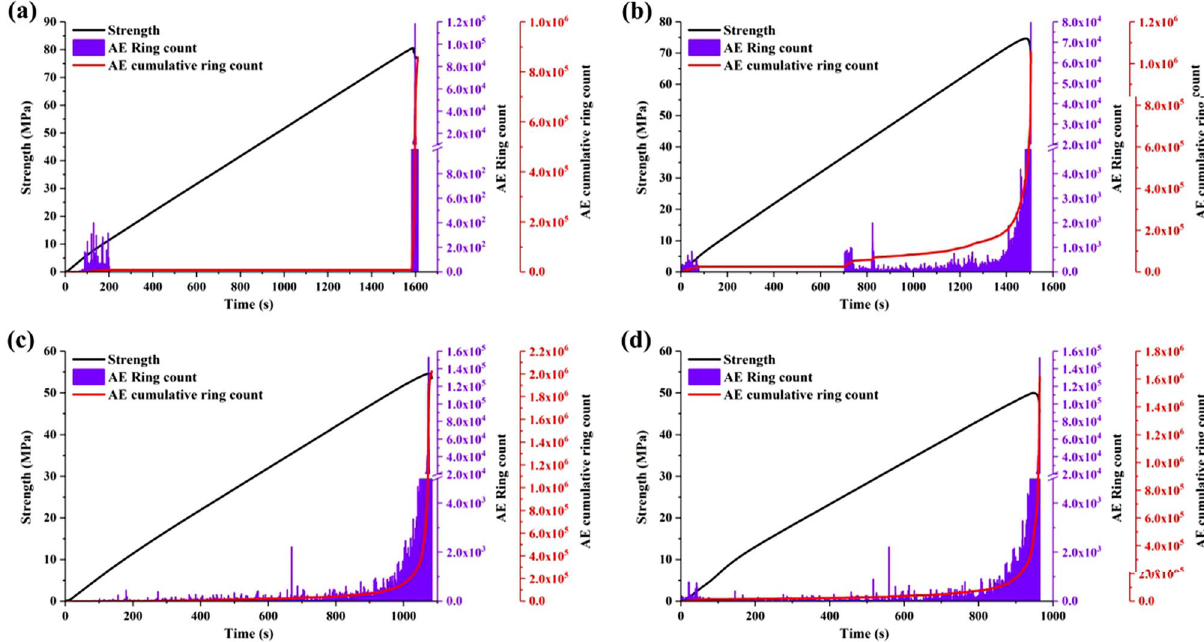
Figure 10. AE ring counts of sandstone under different freeze–thaw times ( a ) 0 freeze–thaw cycles. ( b ) 7 freeze–thaw cycles. ( c ) 14 freeze–thaw cycles. ( d ) 21 freeze–thaw